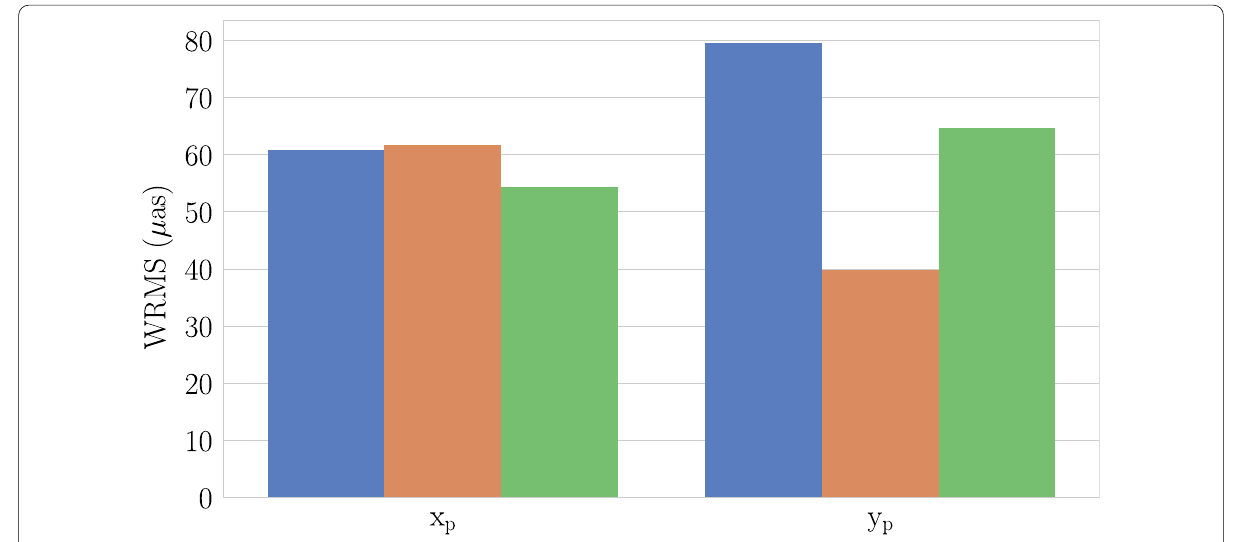
Fig. 13 Polar motion (x p , y p ) WRMS differences w.r.t. IGS PM products for sol‑V (blue), sol‑VG (orange), and sol‑VV (green)